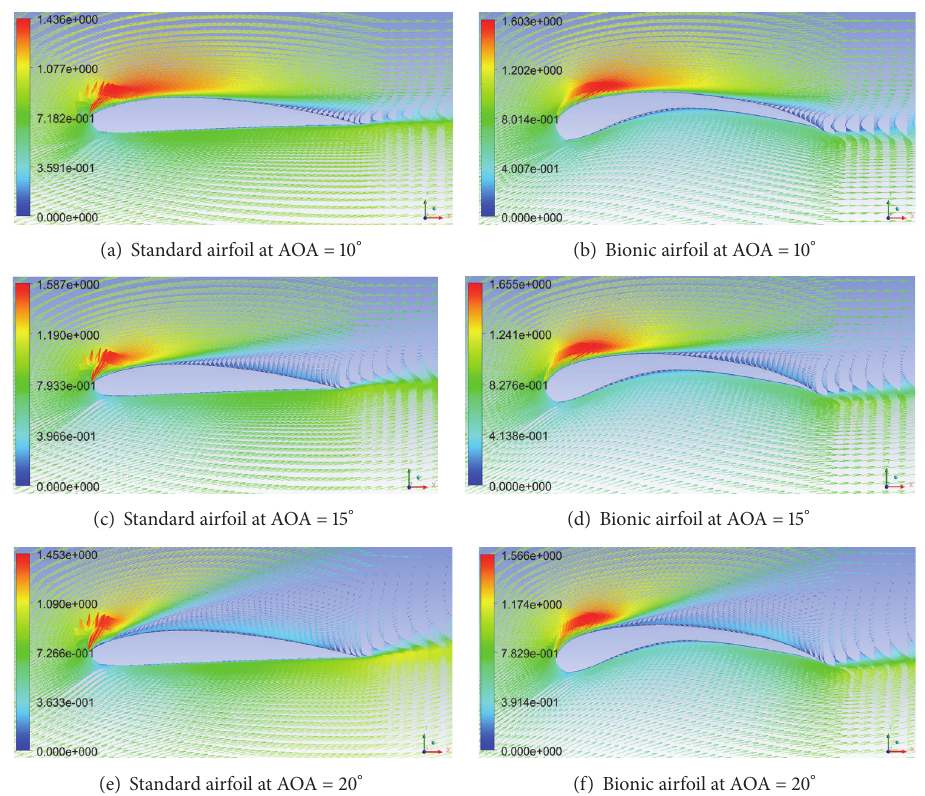
Figure 17: The velocity vectors colored by velocity magnitudes at Re = 6 × 10 4 at different angles of